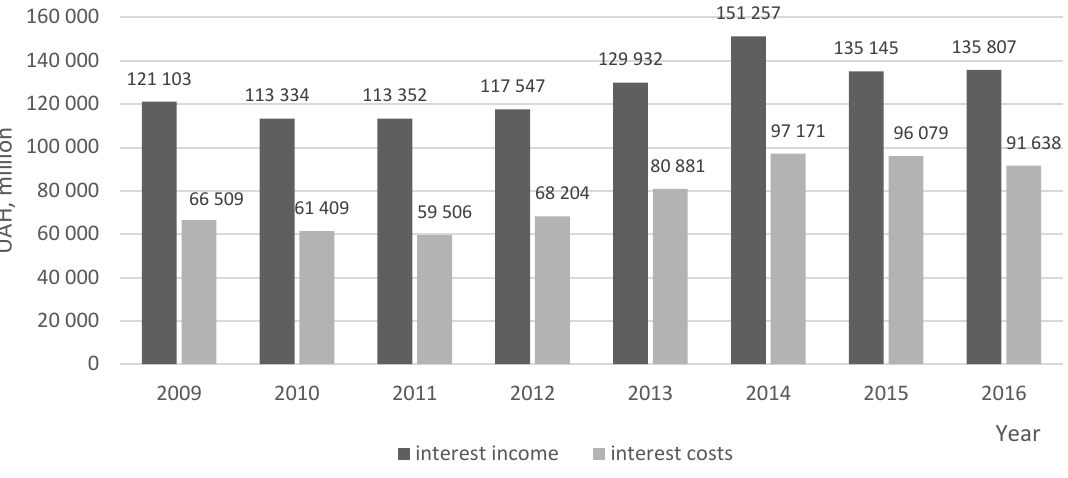
Figure 1. Analysis of the correlation of the value and dynamics of interest income and interest costs in Ukrainian banks in